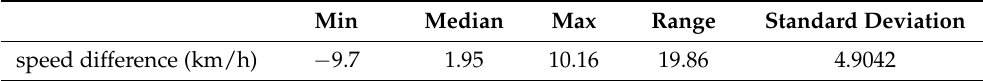
Table 14. Results of space speed difference under coordinated